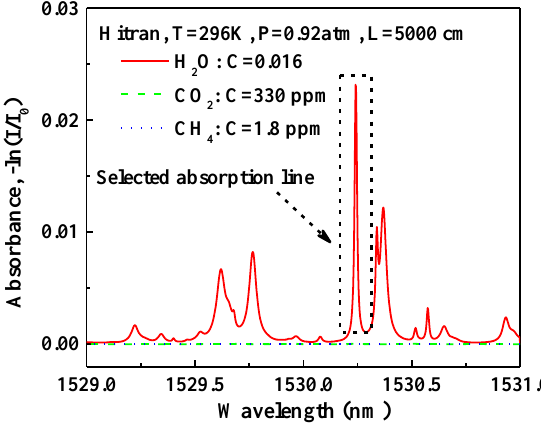
Figure 8. HITRAN-based absorption spectra of H 2 O in a spectral range from 1529 to 1531 nm at a pressure of 0.92 atm and a 50 m absorption length. (C: Concentration) .